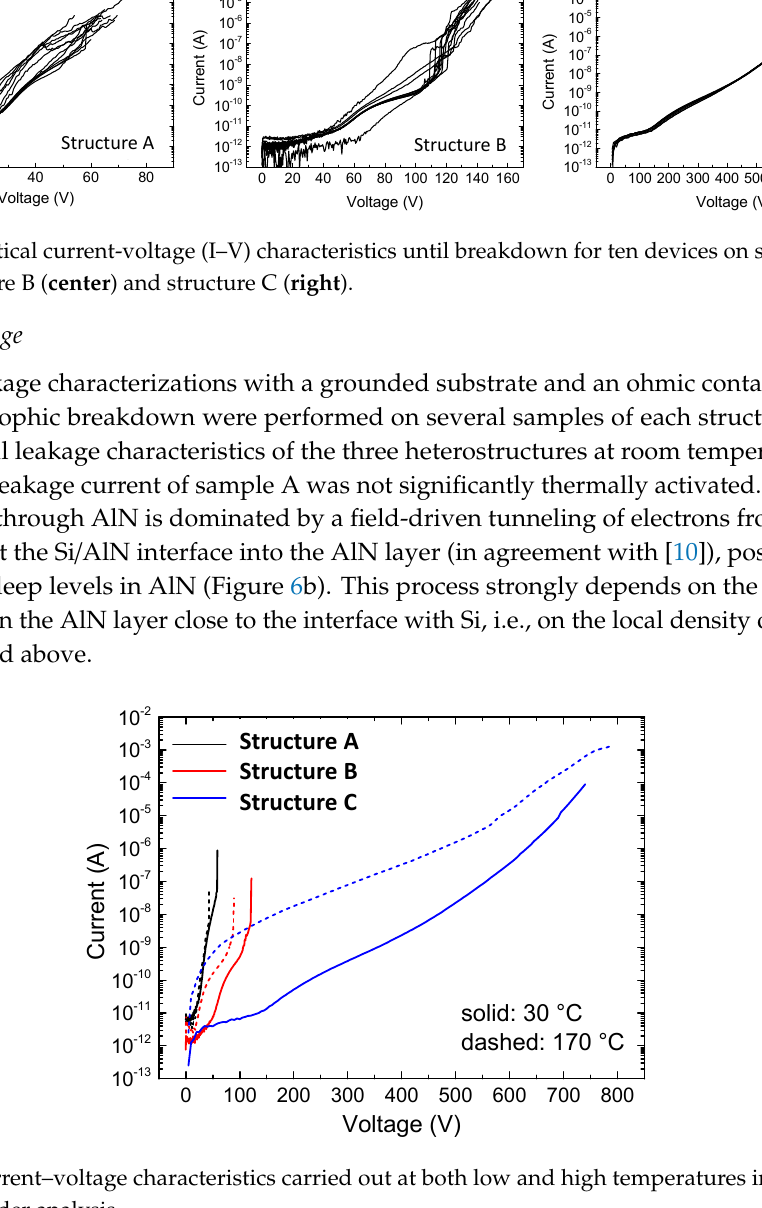
Figure 4. Vertical current-voltage (I–V) characteristics until breakdown for ten devices on structure A ( left ), structure B ( center ) and structure C ( right ).